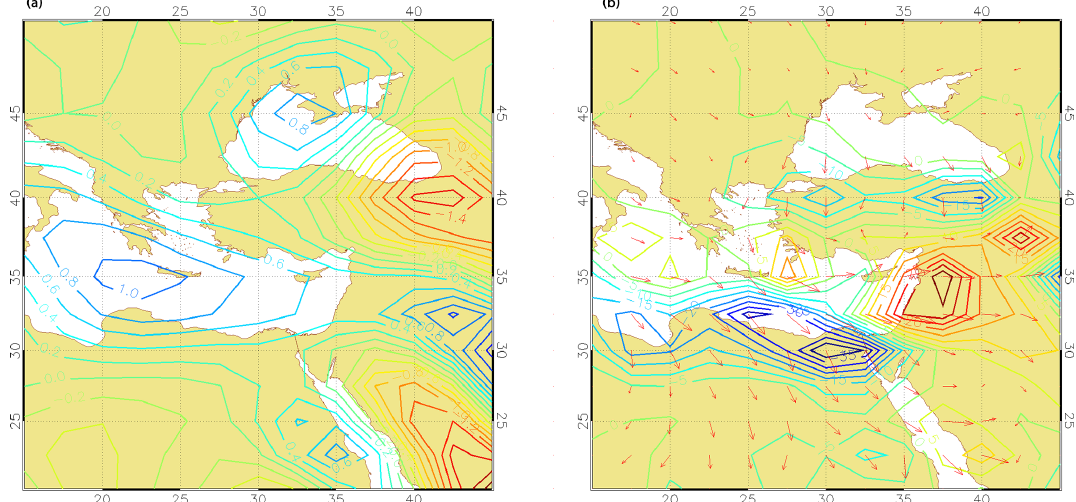
Figure 7. (a) Blue contours display positive omega values (cm s − 1 ) representing the vertical descending air motion at a mid-tropospheric level (700hPa) ( ∼ 3kma . s . l . ) pointing at a core of 1cms − 1 located over Crete. Red contours are negative omega values. (b) Blue contours display cold advection calculated as multiplication of the horizontal thermal gradient by the wind vector. Red contours indicate warm advection, both at 995hPa level, equivalent to about 140ma . s . l . at 12:00UTC during Persian Trough summer synoptic conditions. NCEP reanalysis data for 2000–2012 are provided by the NOAA/OAR/ESRL PSD, Boulder, Colorado, USA; http://www.esrl.noaa.gov/psd/.